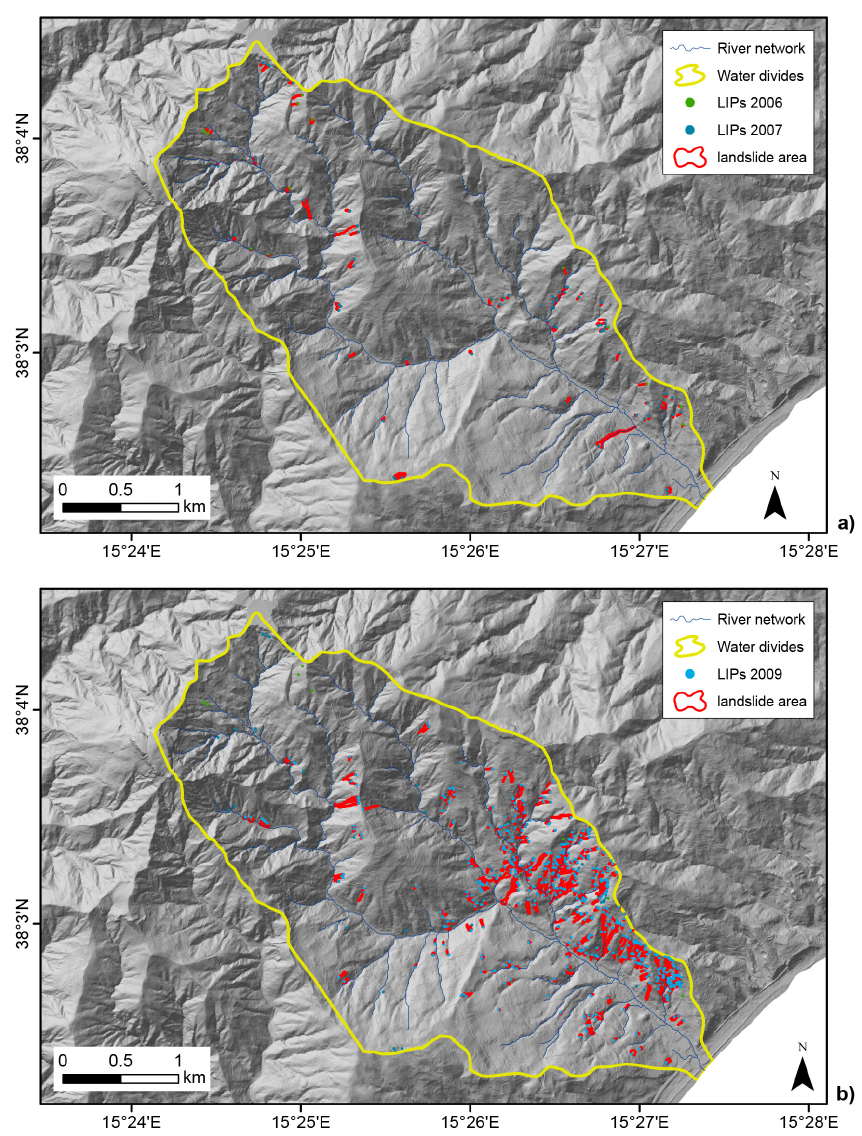
Figure 6. Debris flow event inventories: (a) 2007 inventory containing 73 debris flows; (b) 2009 inventory containing 616 debris